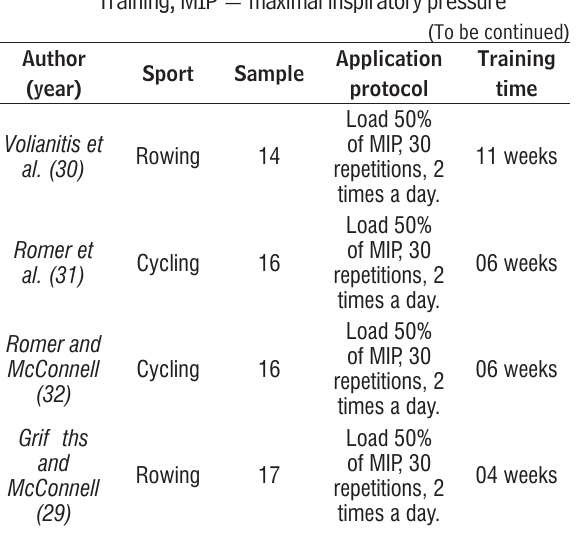
Table 2 - Inspiratory muscle training protocols (TMI) and as- sociation with the sport. IMT = Respiratory Muscle Training; MIP = maximal inspiratory